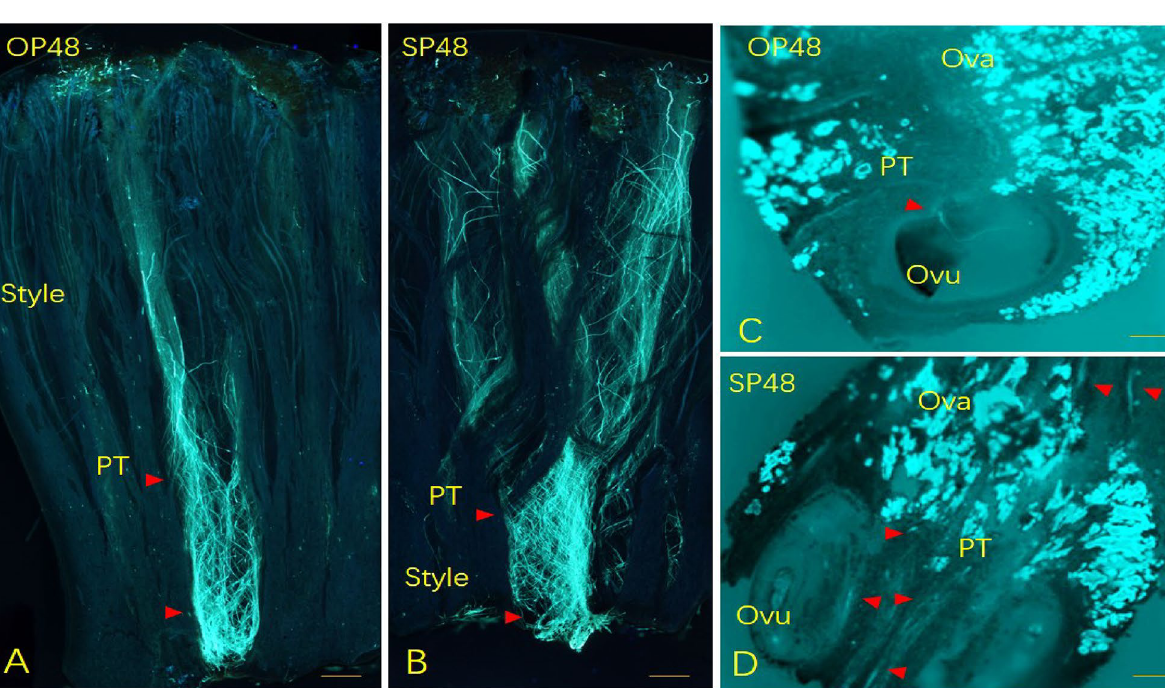
Figure 2. Pollen tubes growth of S. superba during SP and OP at 48 h in style and ovary. PTs during OP at 48 h in the style ( A ) and ovary ( C ), and they were during SP at 48 h in the style ( B ) and ovary ( D ). PTs were shown by red arrows. SEM resolution of 200